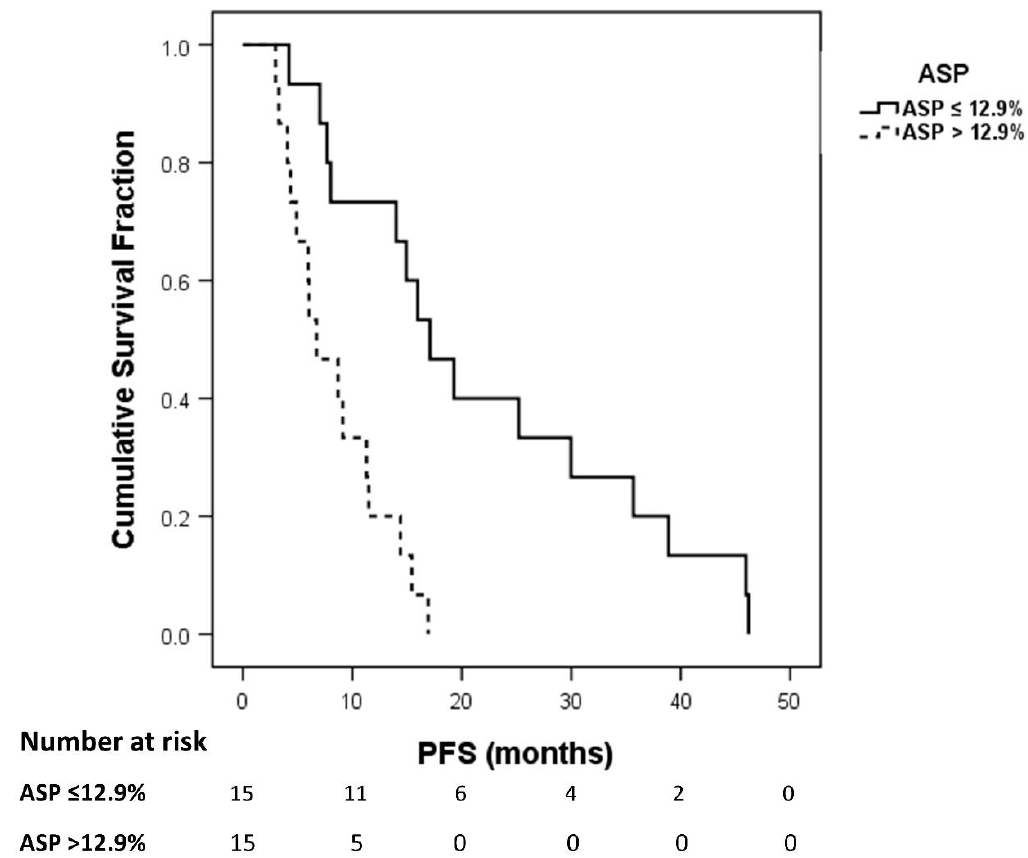
Figure 5. Kaplan–Meier plot of progression-free survival (PFS) for patients with high versus low asphericity (ASP; optimal cut-off, >12.9%).